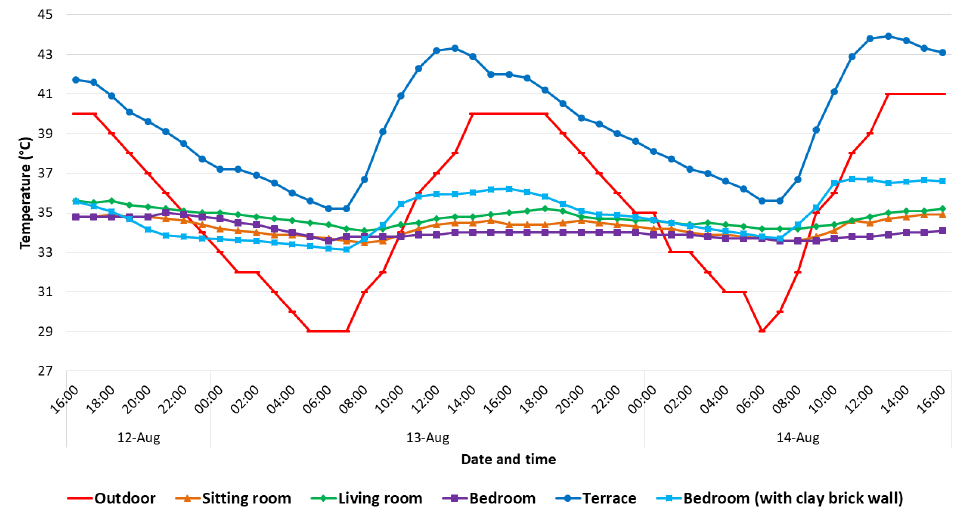
Figure 11. Trend of the indoor temperatures against the outdoor temperature during 12–14 August.